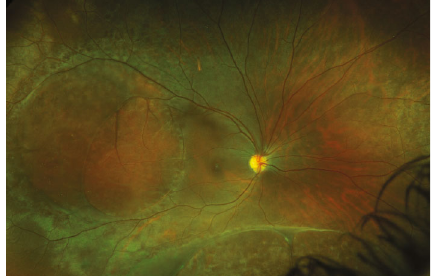
Figure 4: Wide fi eld fundus photo of the right eye showing the resolution of vitreous hemorrhage, vitreous debris, and intraretinal macular hemorrhages.